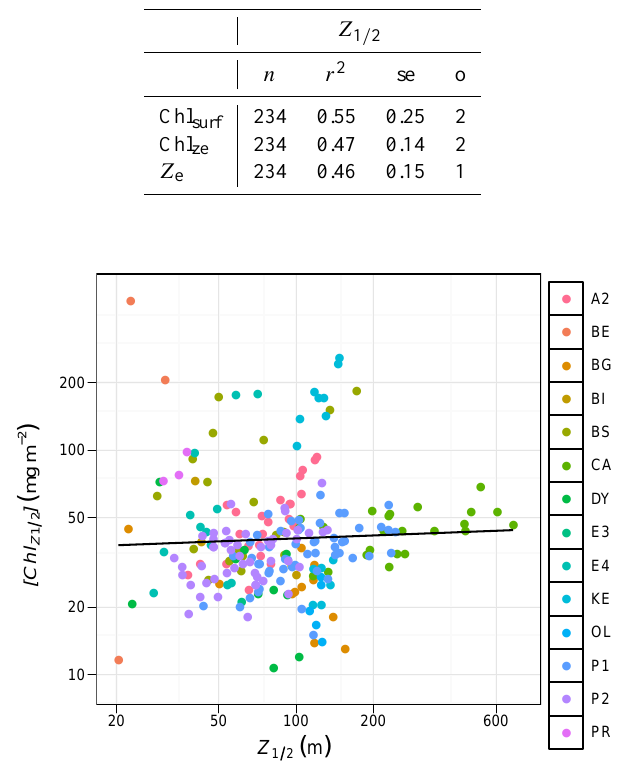
Fig. 6. Sigmoid profiles: Scatterplot of log 10 -transformed [Chl Z 1 / 2 ] (mgm − 2 ) as a function of log 10 -transformed depth- dependent shape parameter Z 1 / 2 (m). Colours refer to the different cruises/projects (see Table 2 for the abbreviations). The line is the linear regression fit within the